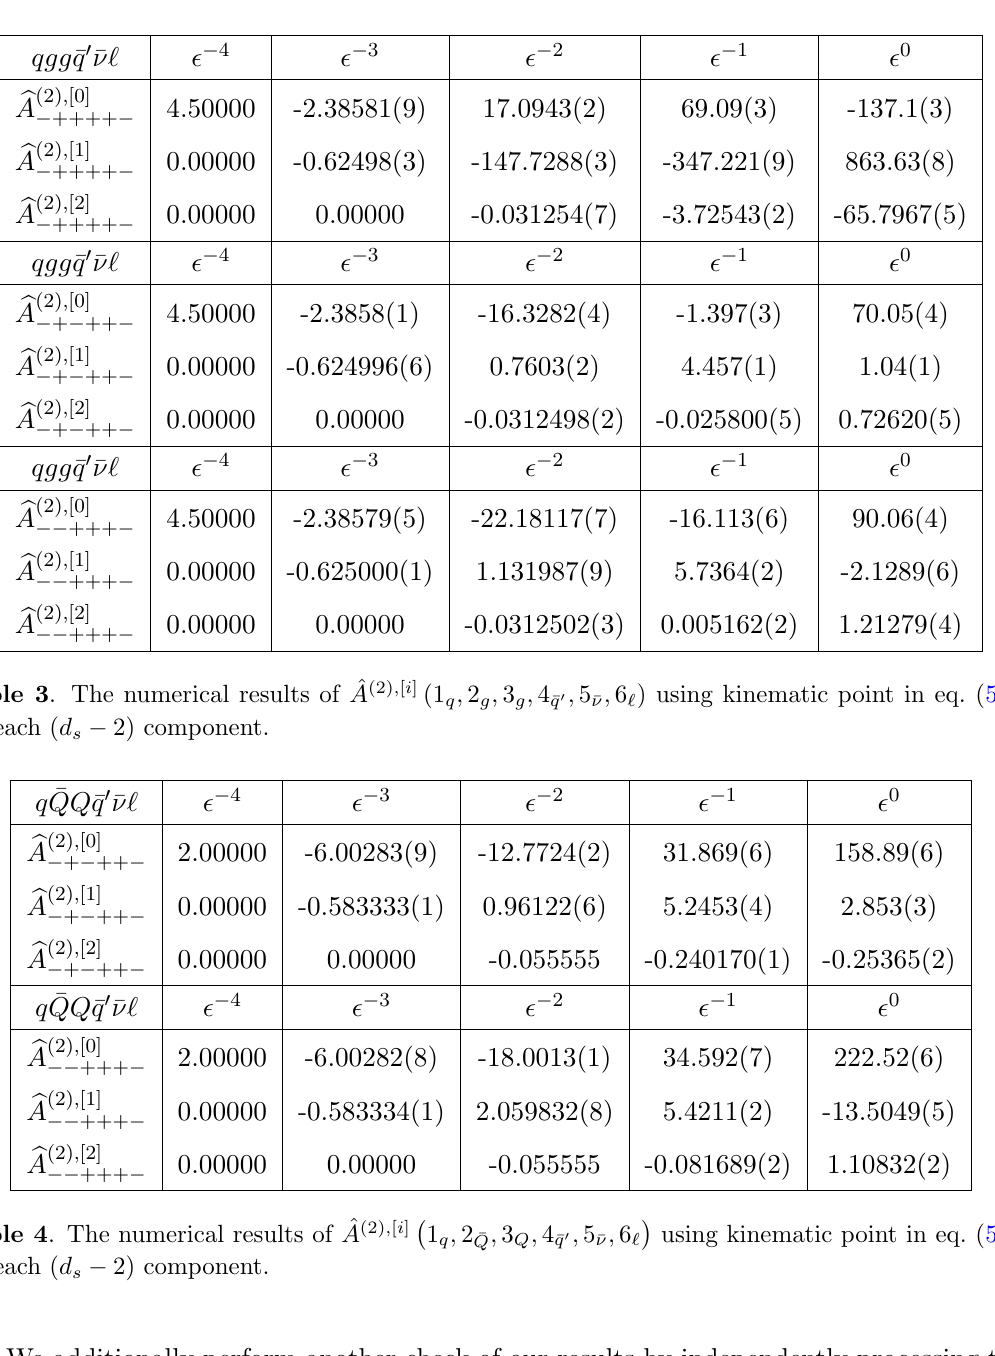
Table 4 . The numerical results of ^ A (2) ; [ i ] for each ( d s 2) (cid:0)